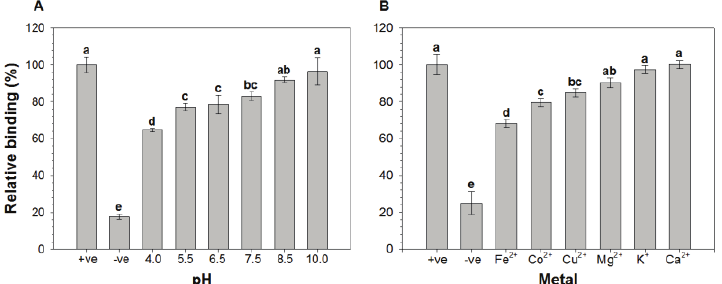
Figure 1. Effect of ( A ) pH and ( B ) metal ions on the relative binding (RB) of hepatitis A virus (HAV) to oyster digestive cells. The cells were exposed to HAV in buffer solutions at the indicated pHs or with the indicated metal ions. The RB was determined using ELISAs by comparing the optical densities of the test samples with that of a positive control (+ve), which consisted of cells exposed to HAV in distilled water. The negative control ( − ve) consisted of the cells in distilled water without HAV. Bars labeled with different letters significantly differ from one another ( p < 0.05; Tukey’s HSD